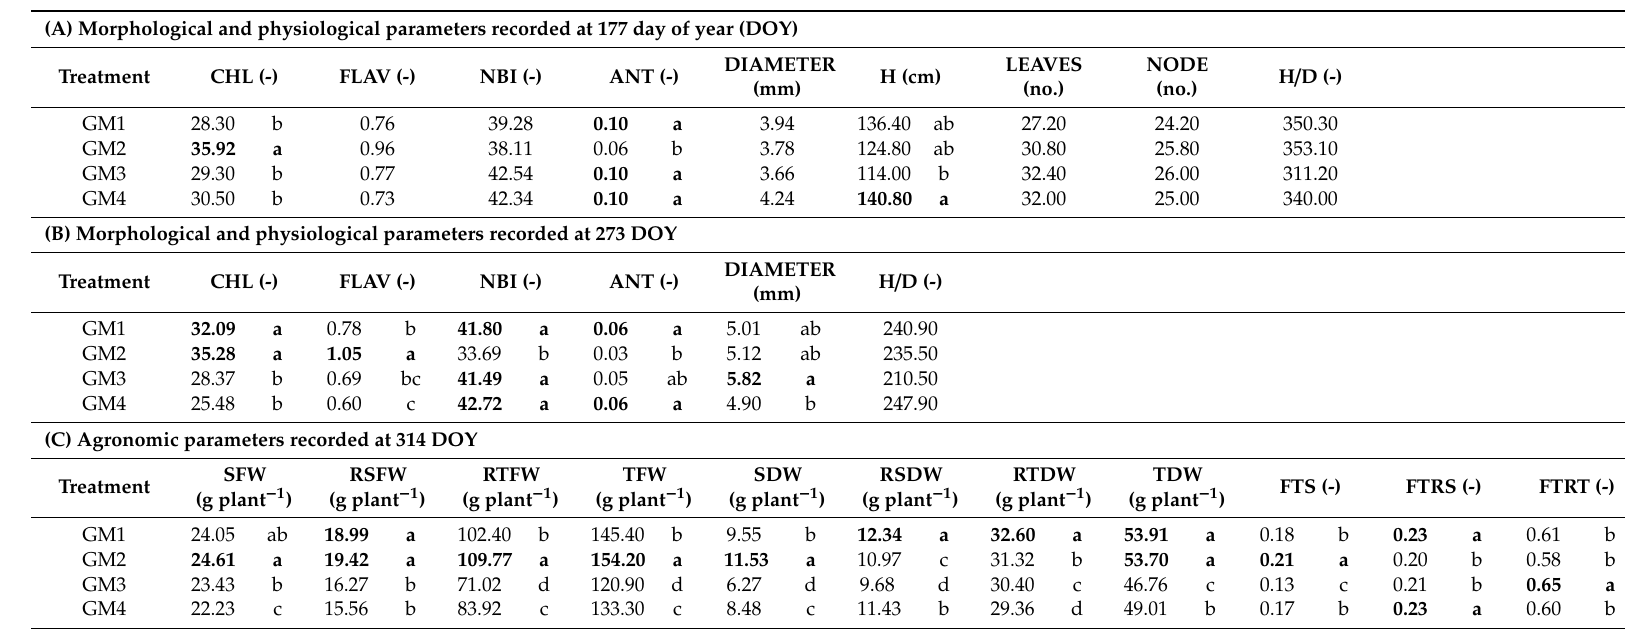
Table 5. Parameters recorded on bare-rooted vines grown on growing media containing composted solid